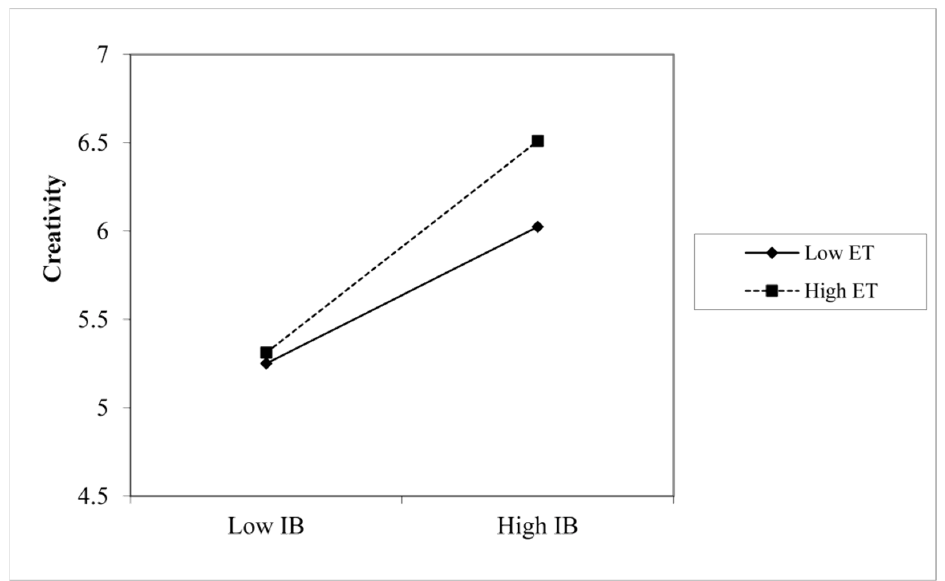
Figure 2. Moderation of environment turbulence on the relationship between interactive budget and innovation performance.